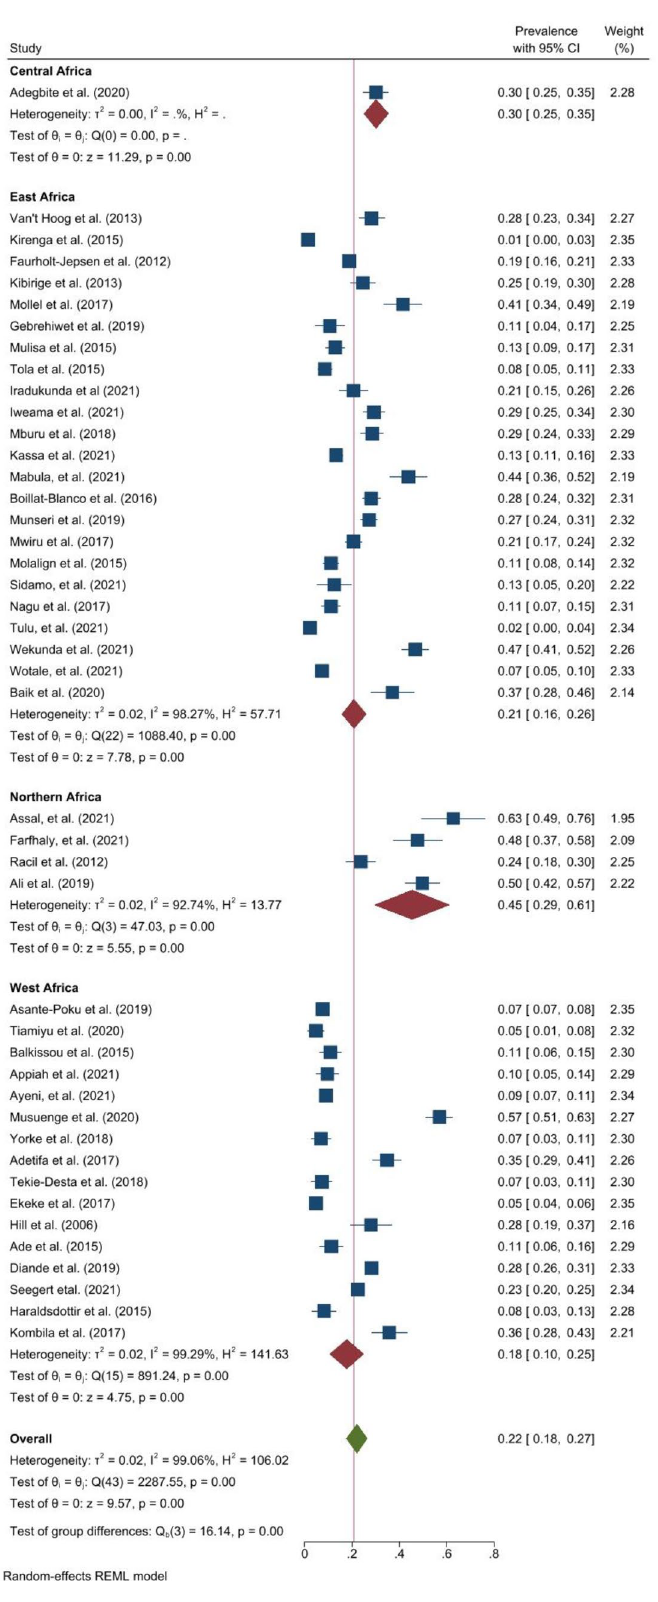
Figure 2. Forest plot showing the pooled prevalence of smoking among people with active TB in East, West, Northern and Central